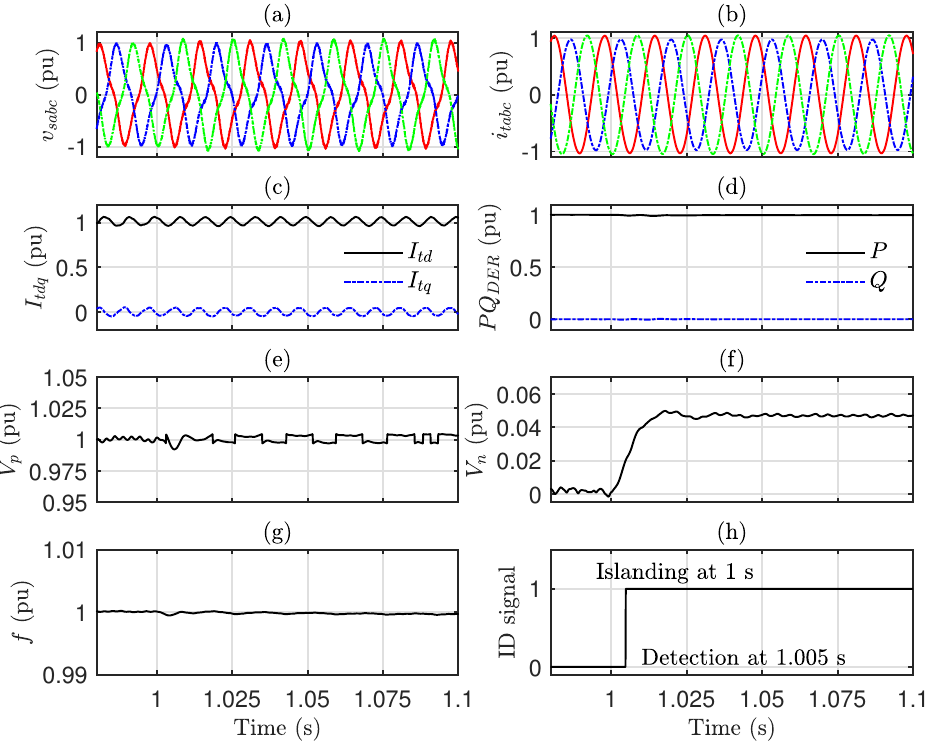
Figure 12. LCL -type filter case. Performance of the proposed controller under the IEEE1547 anti- islanding test: ( a ) three-phase PCC voltages; ( b ) three-phase inverter terminal currents; ( c ) d - and q -axis components of inverter terminal current; ( d ) fundamental frequency power components of the DER unit; ( e , f ) amplitude of positive- and negative-sequence voltages at PCC, respectively; ( g ) frequency; and ( h ) ID signal.